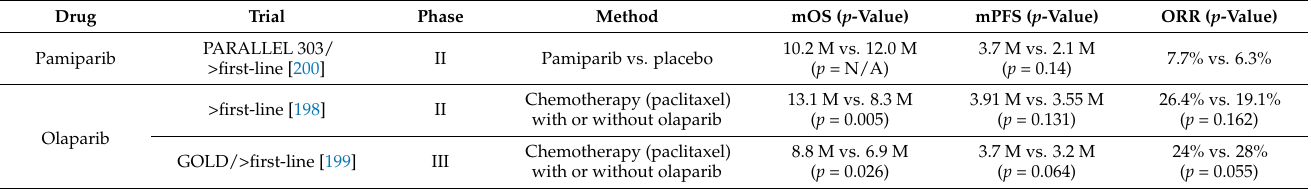
Table 8. Phase II and III trials of therapies targeting poly (ADP-ribose) polymerase. mOS, median overall survival; mPFS, median progression-free survival; HR, hazard ratio; M, months; ORR, objective response